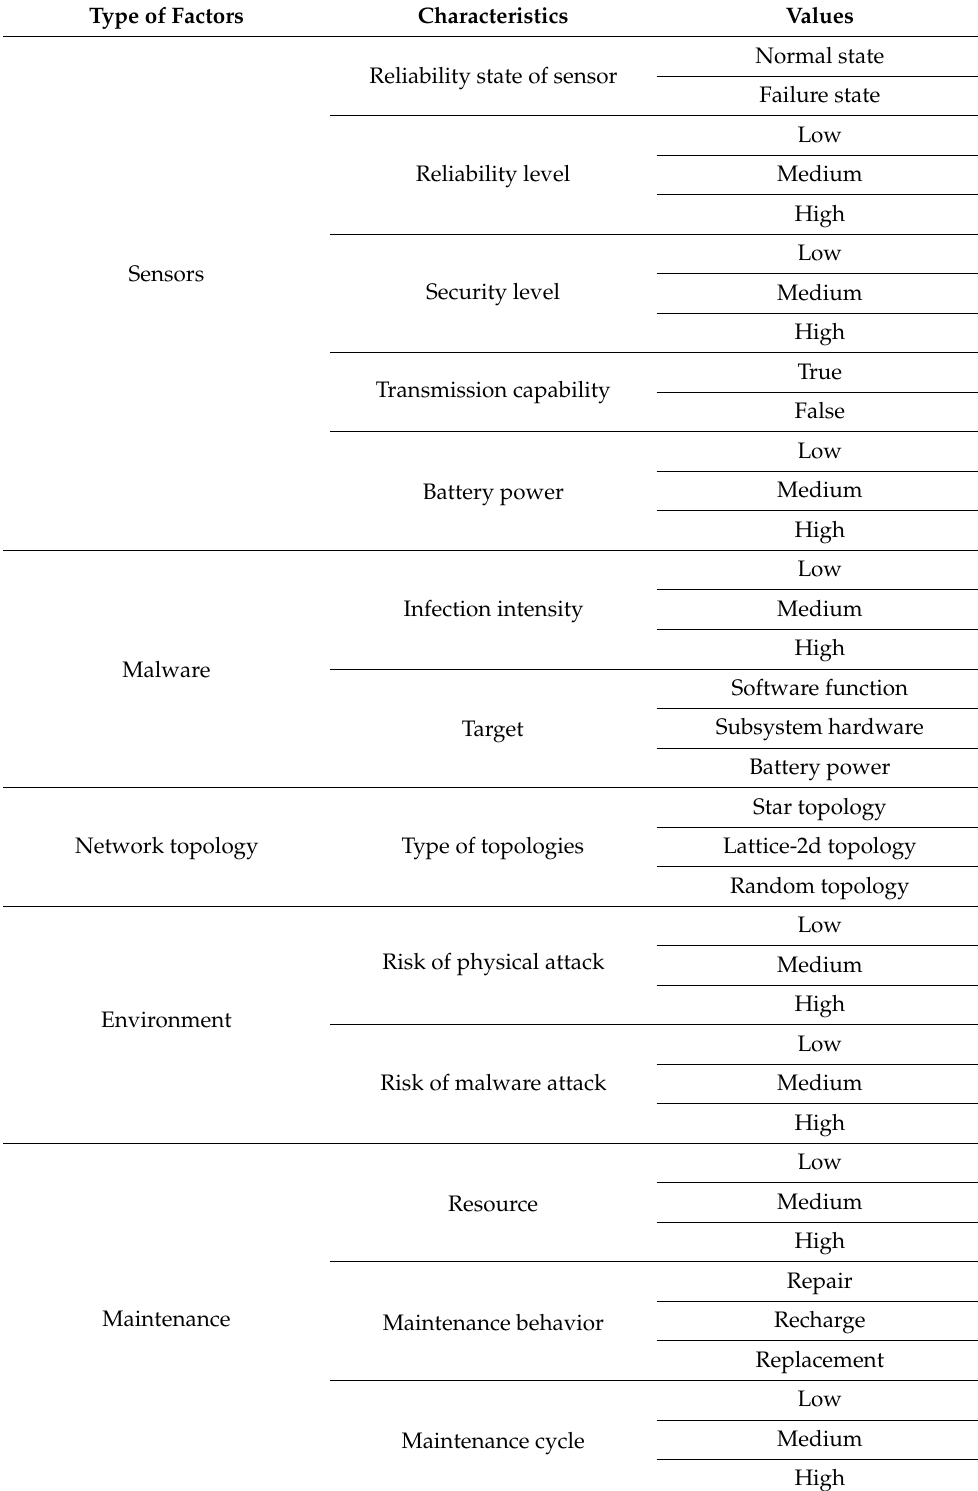
Table 1. Factors with their